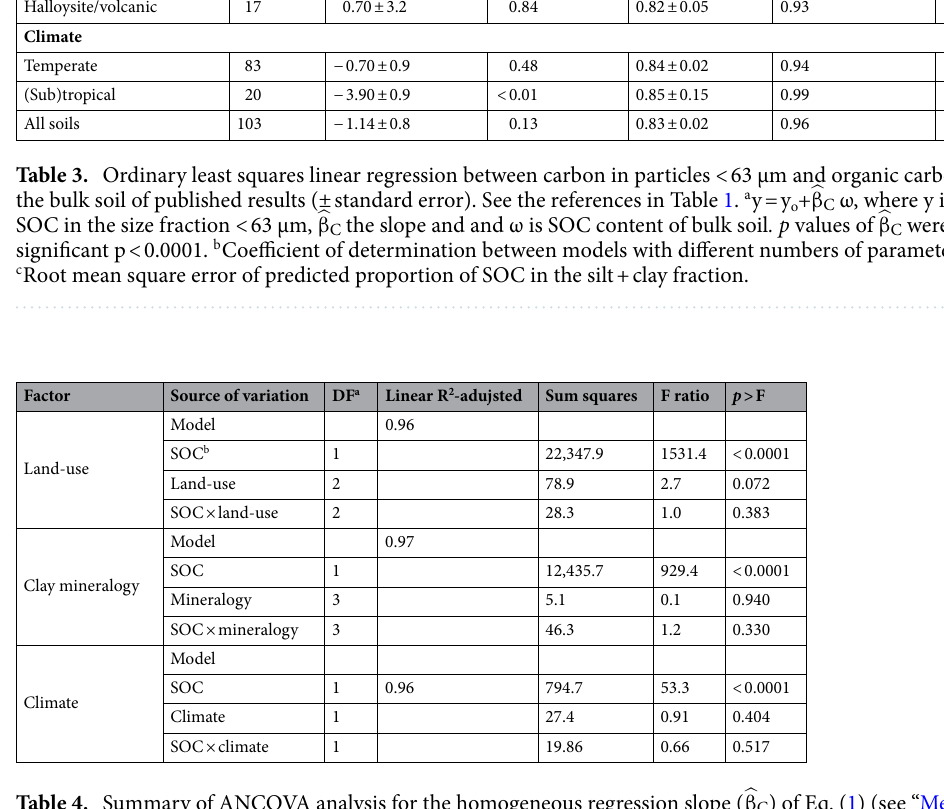
Table 4. Summary of ANCOVA analysis for the homogeneous regression slope ( section) between the carbon in the sil + clay particle (< 63 µm) and the carbon in the bulk soil of published results. See references in Table 1. a Degree of freedom. b Soil organic carbon.